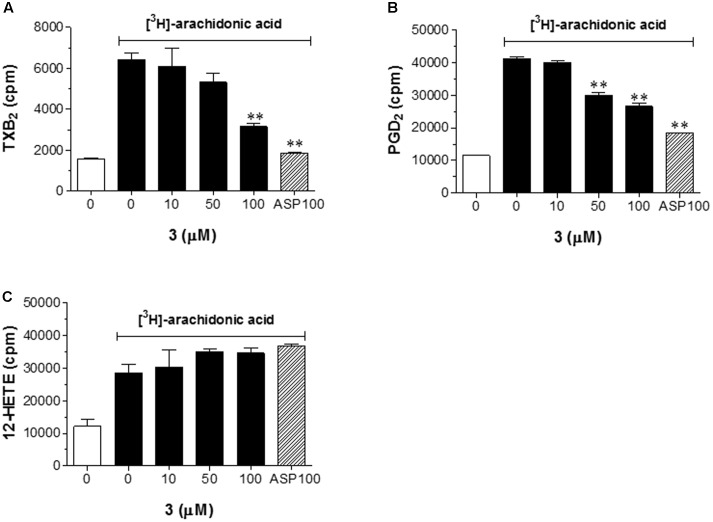
3 suppresses the formation of TXB2 and PGD2. AA-mediated formation of [3H]-TXB2
(A), [3H]-PGD2
(B), or [3H]-12-HETE (C) was assayed. [3H]-TXB2, [3H]-PGD2, and [3H]-12-HETE were extracted and separated by TLC on silica gel G plates. The area corresponding to each lipid was scraped off, and radioactivity was measured by liquid scintillation counting. The results shown in bar graphs expressed as the means ± SEM are an average of three similar and independent experiments. ∗∗p < 0.01 vs. control ([3H]-AA treatment, but no 3).